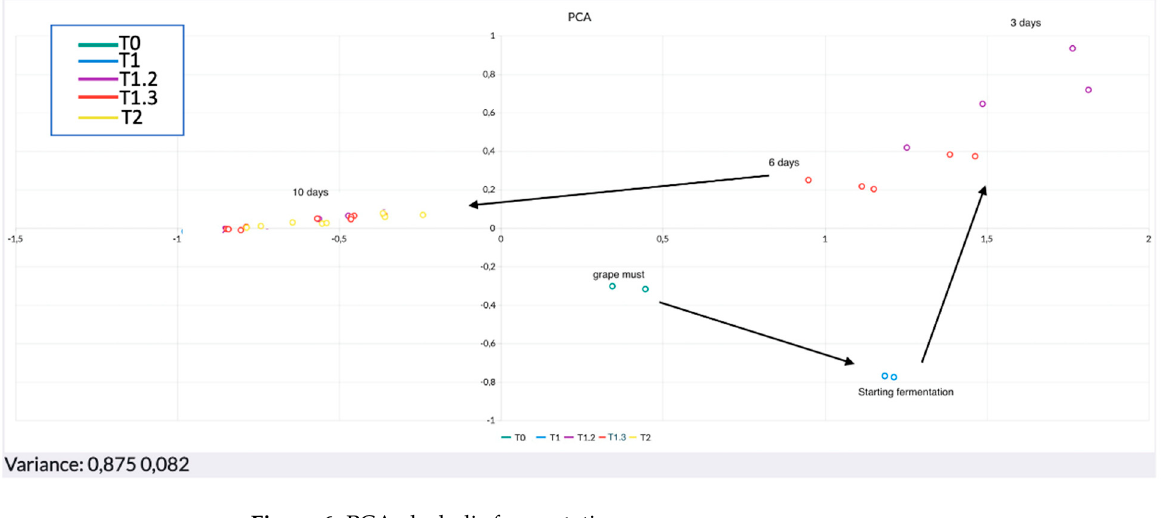
Figure 6. PCA alcoholic fermentation.